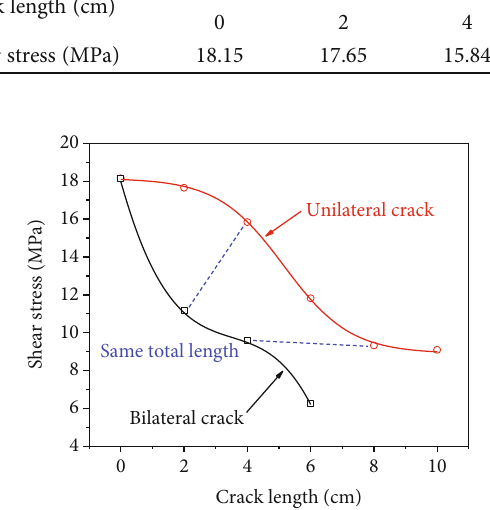
Figure 6: Fitting curves of peak shear stress of specimens with di ff erent